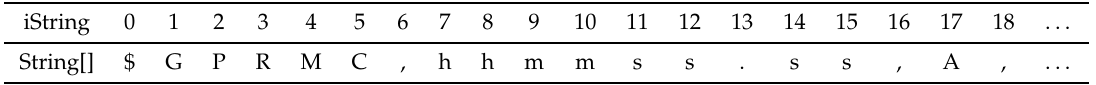
Table 1. Characters of interest in the $GPRMC command.